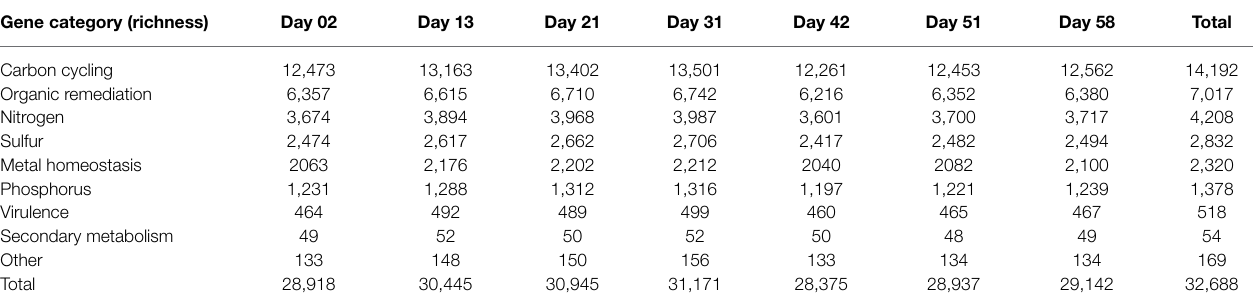
TABLE 1 | The richness of functional gene categories detected at different culture stages. Gene category (richness) Day